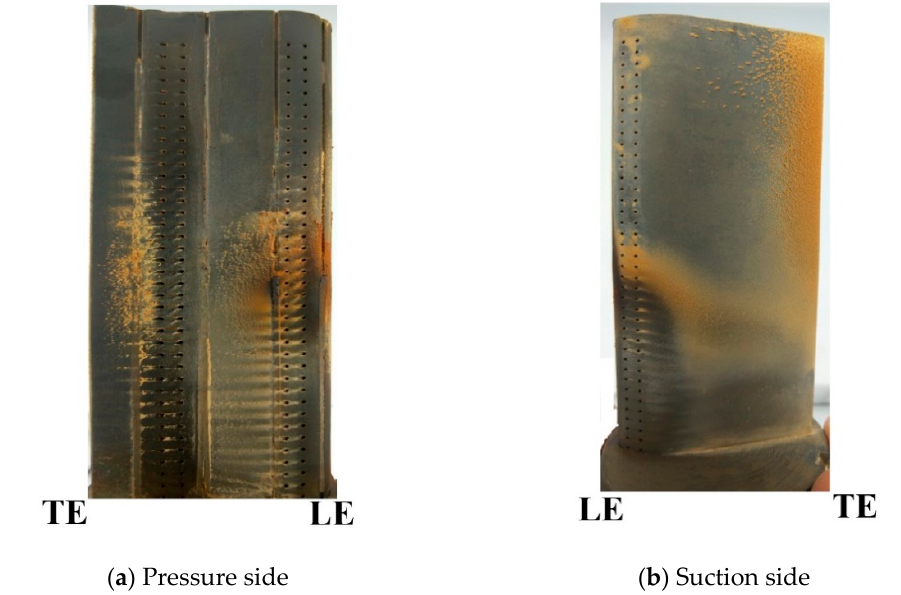
Figure 14. Photos of the sand deposition on the ( a ) pressure and ( b ) suction sides of the test model at the mainstream temperature of 1668 K.